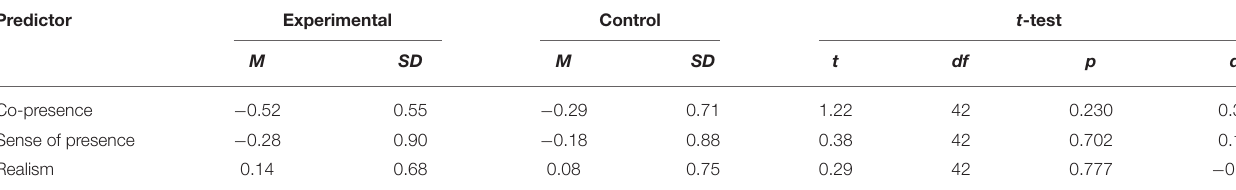
TABLE 2 | T -test results comparing the experimental and control group on considered moderators. Predictor Experimental Control t -test